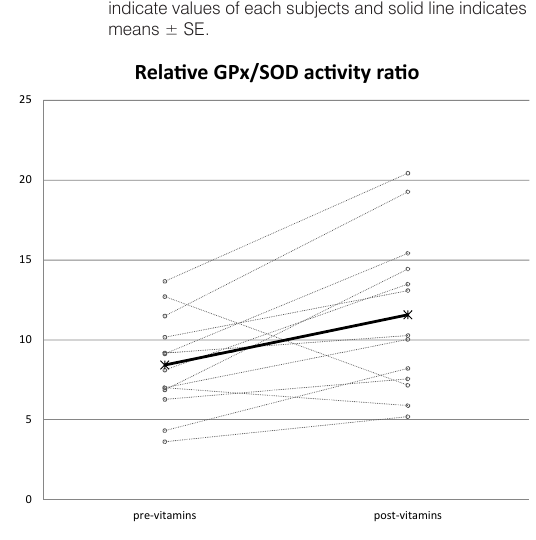
Figure 3. Heart rate increased significantly after exercise in the cycle ergometer group compared to the 6-min walk test (6MWT) group (p<0.05). Values are means ± SE. bpm; beats per